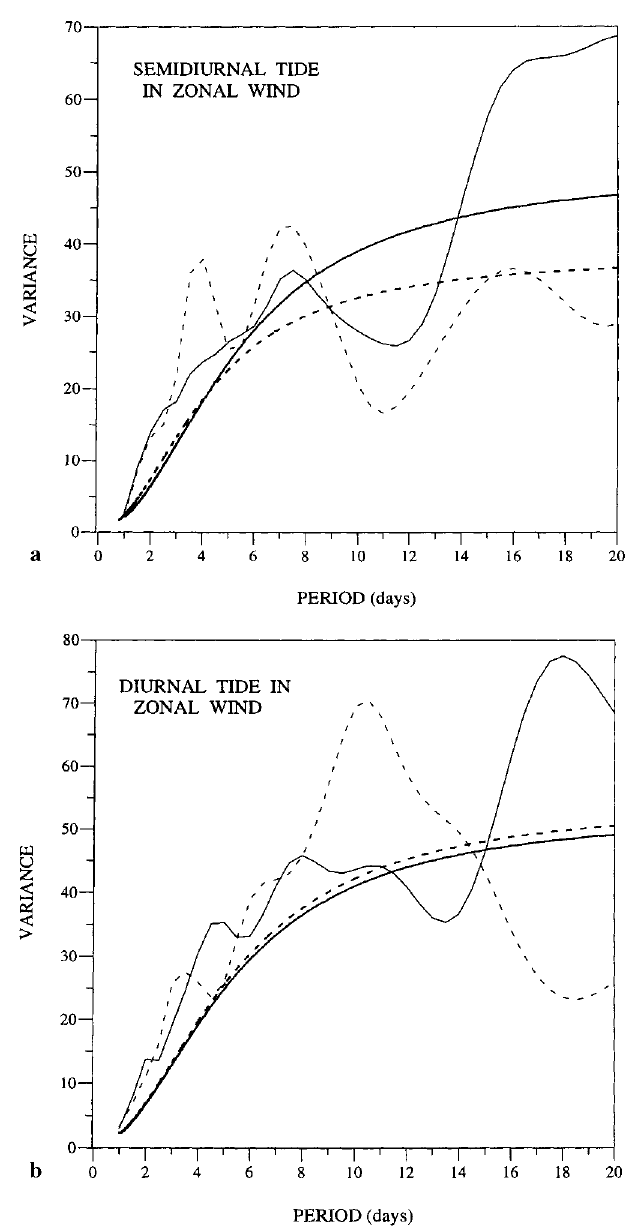
Fig. 11. a The wavelet power spectra, normalized by the variance of the time series, for the amplitudes of the semidiurnal zonal tide ( solid line , for the first subinterval, dashed line , for the second subinterval). The thick solid ( dashed ) line represents the 95% confidence level for the first (second) subinterval of the measurements. b The same as a , but for the amplitudes of diurnal